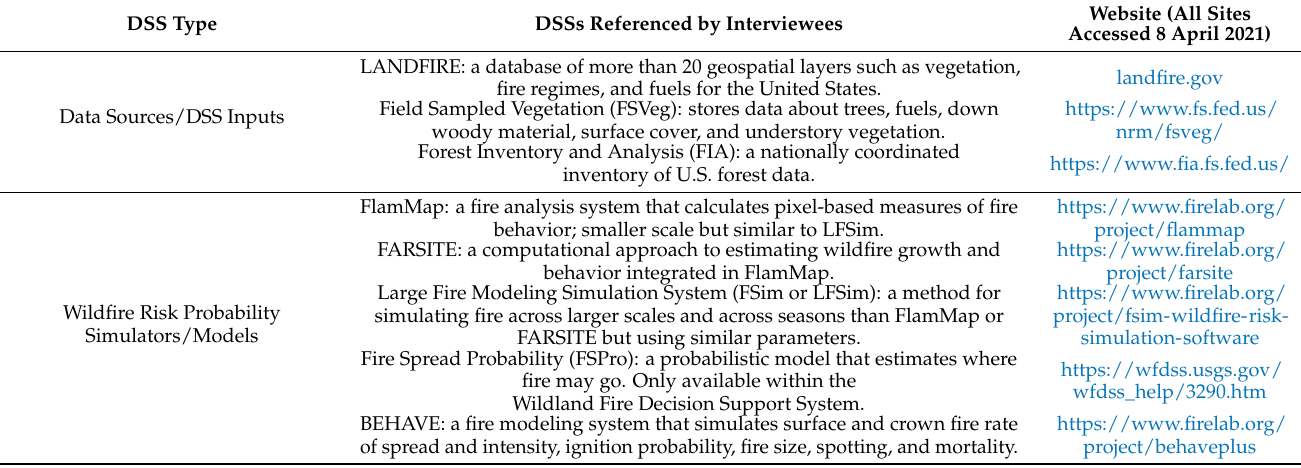
Table 4. DSS types and DSSs referenced by interviewees; not a comprehensive list of DSSs for wildfire risk assessment and treatment prioritization planning. Websites where these DSSs can be accessed are provided where